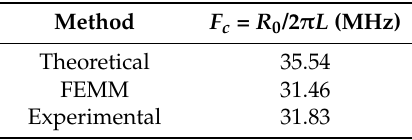
Table 1. Cut-off frequencies in the ILS for each of the analysis methods applied.